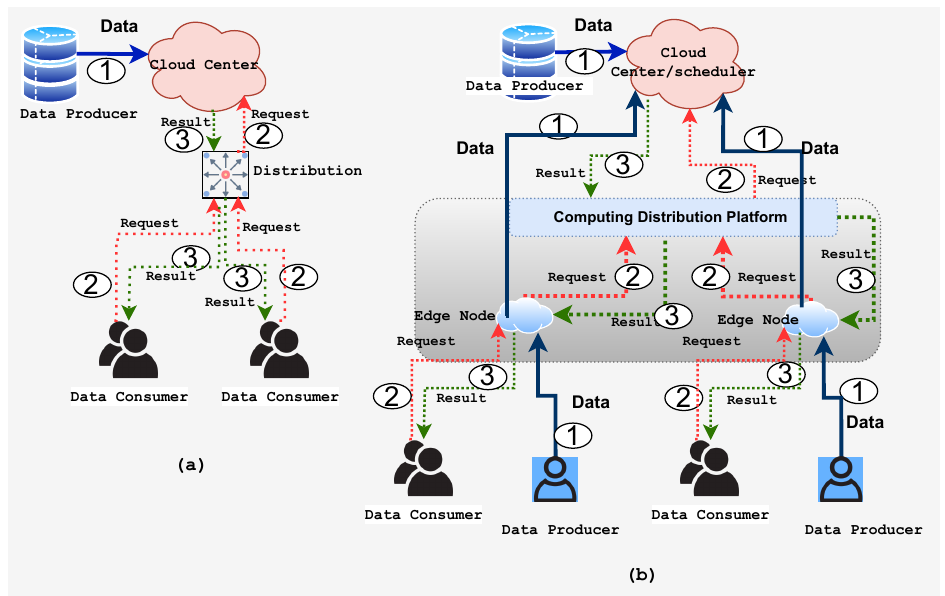
Figure 2. ( a ) Cloud computing paradigm and ( b ) edge computing